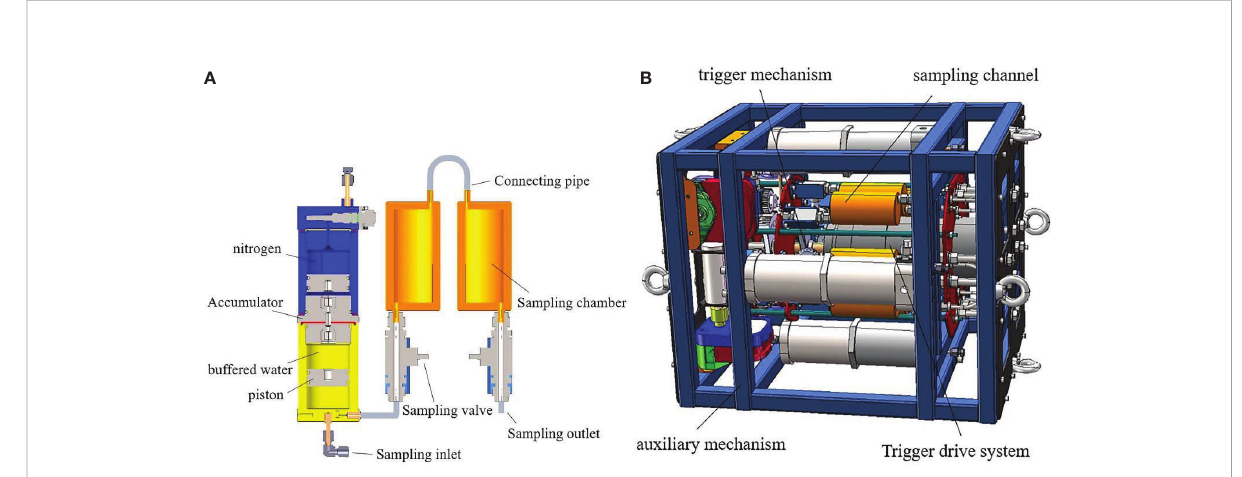
FIGURE 2 Model of the water sampler, (A) Sampling channel, (B) Overall design of the water